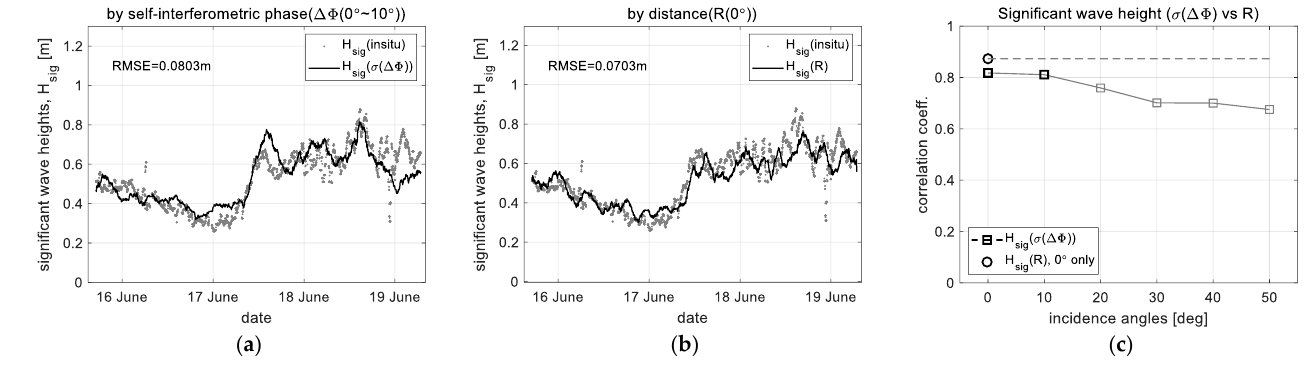
Figure 12. Observation results for significant wave height ( H sig ): ( a , b ) the significant wave heights retrieved by the proposed and existing method, and ( c ) the comparison of correlation coefficients ( σ ( ΔΦ ) vs . R ). Table 2. Comparison of the observational performance for wind speed ( w s ) and significant wave height ( H sig ): ( (2) before and (1) after improving the performance at the high incident angles). Radar Parameters Obs.